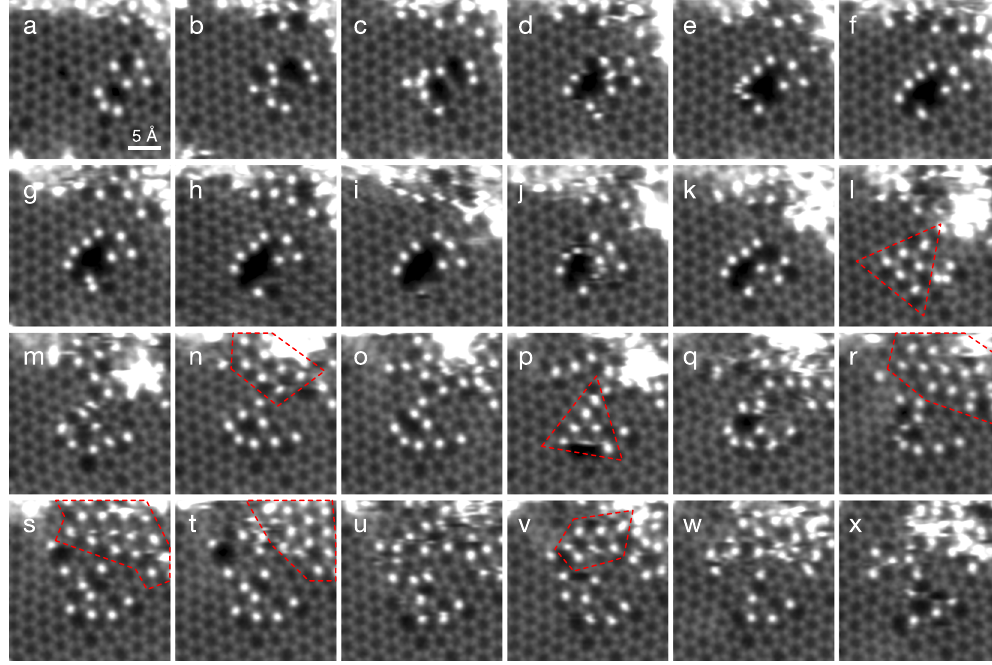
Figure 1. Observed time series of the assembly of atomically thin SiC nanograins. The overlaid red dashed lines indicate the approximate locations of the SiC regions. The triangular patch in panel l was used as the basis for elemental